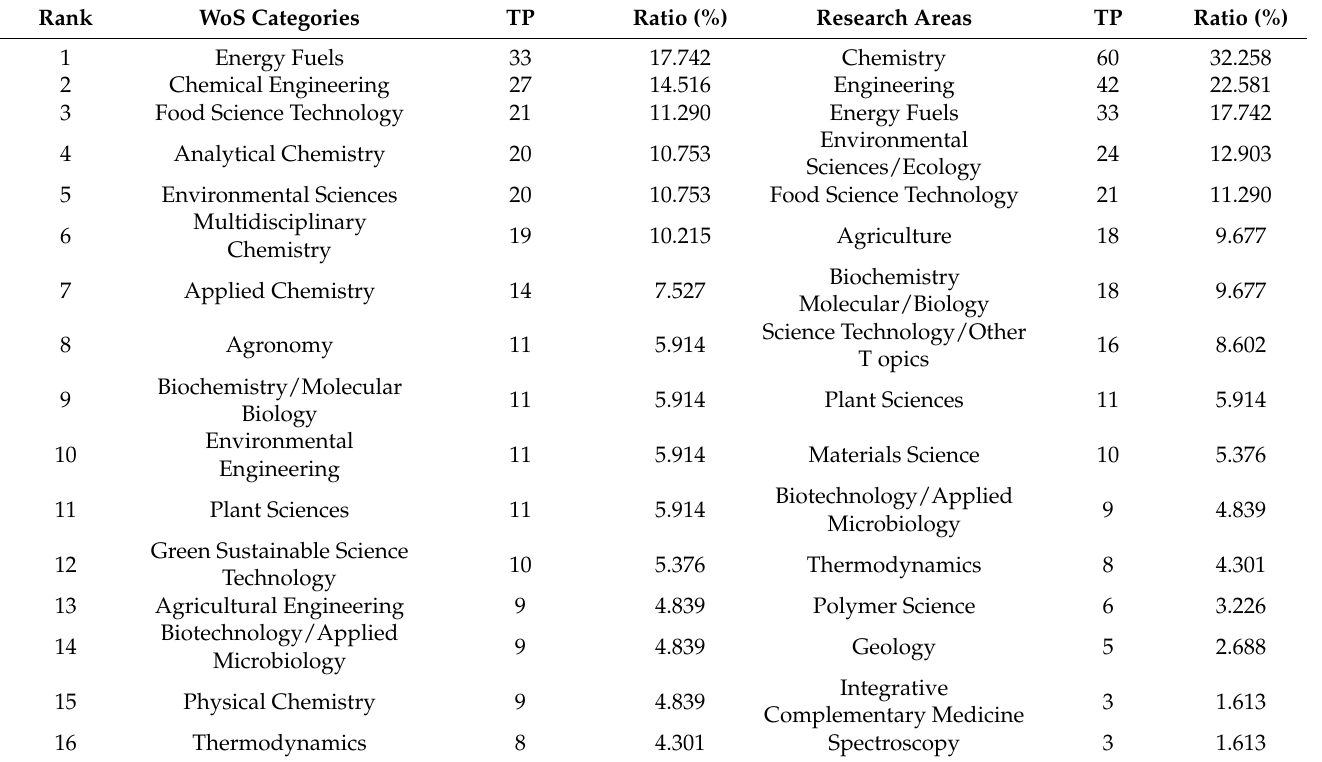
Table 2. Web of Science (WoS) categories and research areas concerning biodiesel production from essential oil.